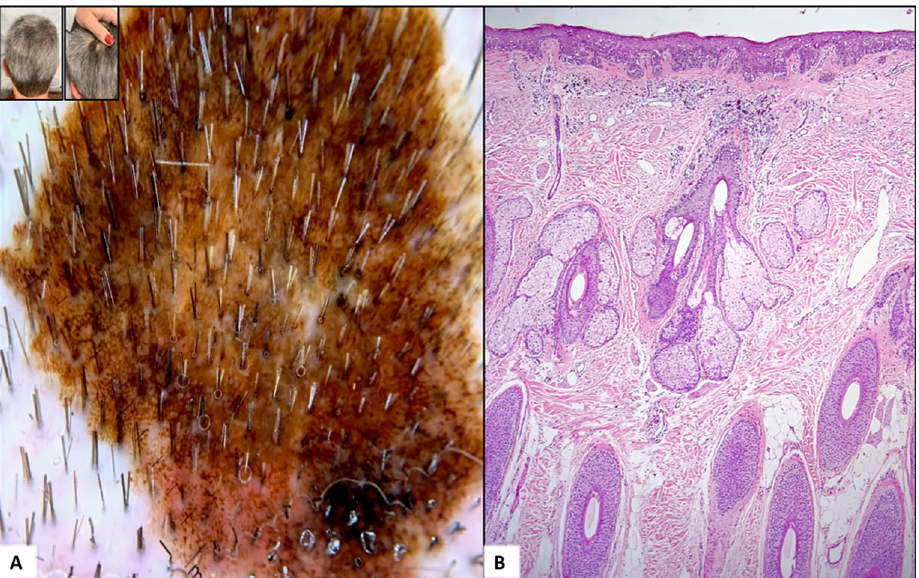
Figure 3. Case of a 54-years-old man with a melanoma hidden by hair, without androgenetic alopecia or chronic sun damage; ( A ) Dermoscopic image of the lesion showing atypical network and globules, off-center blotch, regression structures, and atypical vessels; ( B ) Histopathological examination showing a superficial spreading melanoma, with a Breslow thickness of 0.4 mm, without elastosis or signs of androgenetic